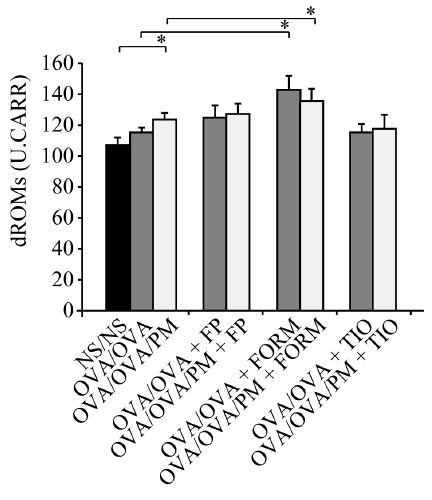
Figure 6. The levels of reactive oxygen metabolites after the administration of fluticasone propionate, formoterol fumarate, and tiotropium bromide. The levels of reactive oxygen metabolites (dROMs) in serum samples obtained on day 27. Fluticasone propionate and tiotropium bromide had no effect on dROM levels compared with the control group, but formoterol fumarate increased dROM levels. Data for each group are expressed as the mean ± standard deviation, with eight mice per group. * p < 0.05.